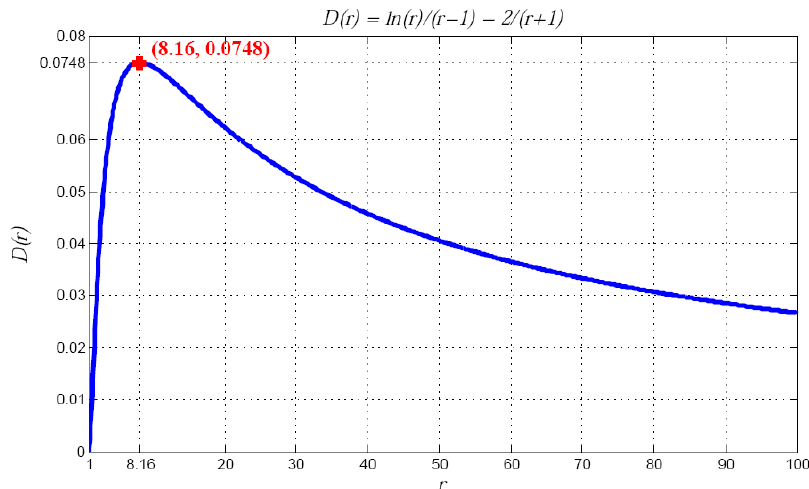
Figure 8. Ratio r of the deepest wetting front to the shallowest one and its influence on D ( r ).